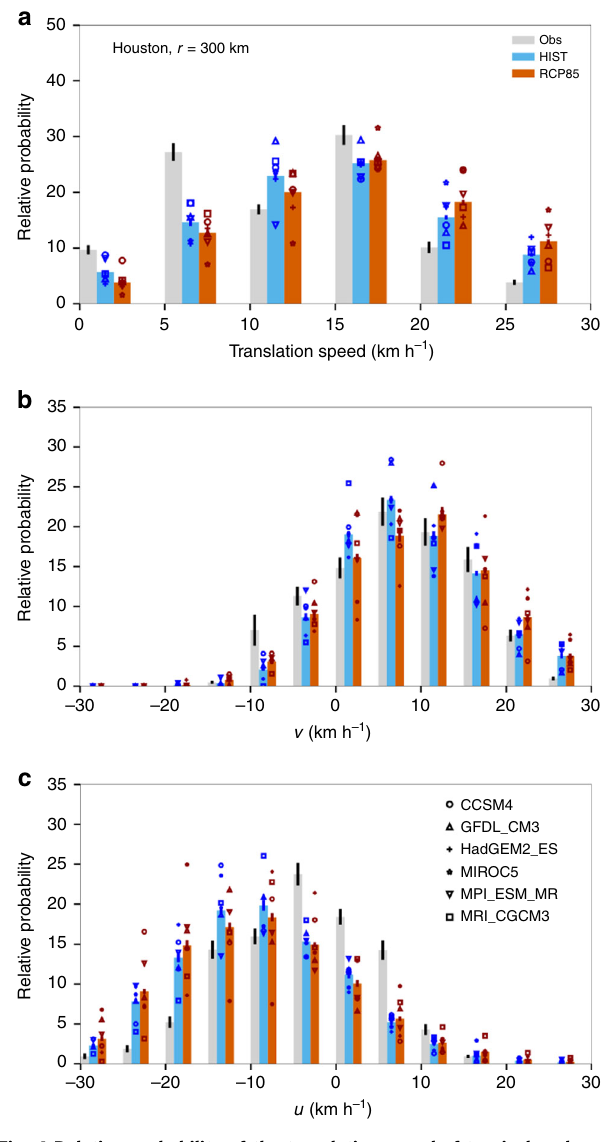
Fig. 4 Relative probability of the translation speed of tropical cyclones (TCs) that pass through an area within 300 km from Houston. a Total speed; b Meridional speed v ; c Zonal speed u . Data from observations (1981 – 2018, gray), and from the HIST (1981 – 2005; blue) and RCP8.5 (2071 – 2099; red) Columbia TC HAZard-Coupled Model Intercomparison Project 5 (CHAZ-CMIP5) downscaling simulations. The observational data are from International Best Track Archive for Climate Stewardship, version 4. The black vertical lines in gray bars show one standard deviation from observations while the symbols along the blue and red bars show the mean values from individual CMIP5 models. See Methods for further details. In a , there is ~10% shift from the relative probability of slow-moving TCs toward that of fast-moving TCs under RCP8.5 (see text). In b , there is ~9.8% shift from the relative probability of slow-moving TCs (| v | ≤ 5kmh − 1 ) toward that of fast-moving TCs (northward speed v ≥ 15kmh − 1 ) under RCP8.5. In c , there is ~2.9% shift from the relative probability of slow-moving TCs (| u | ≤ 5kmh − 1 ) toward that of fast-moving TCs (westward speed u ≥ 15kmh − 1 ). Supplementary Fig. 17 shows the same analysis but with bias